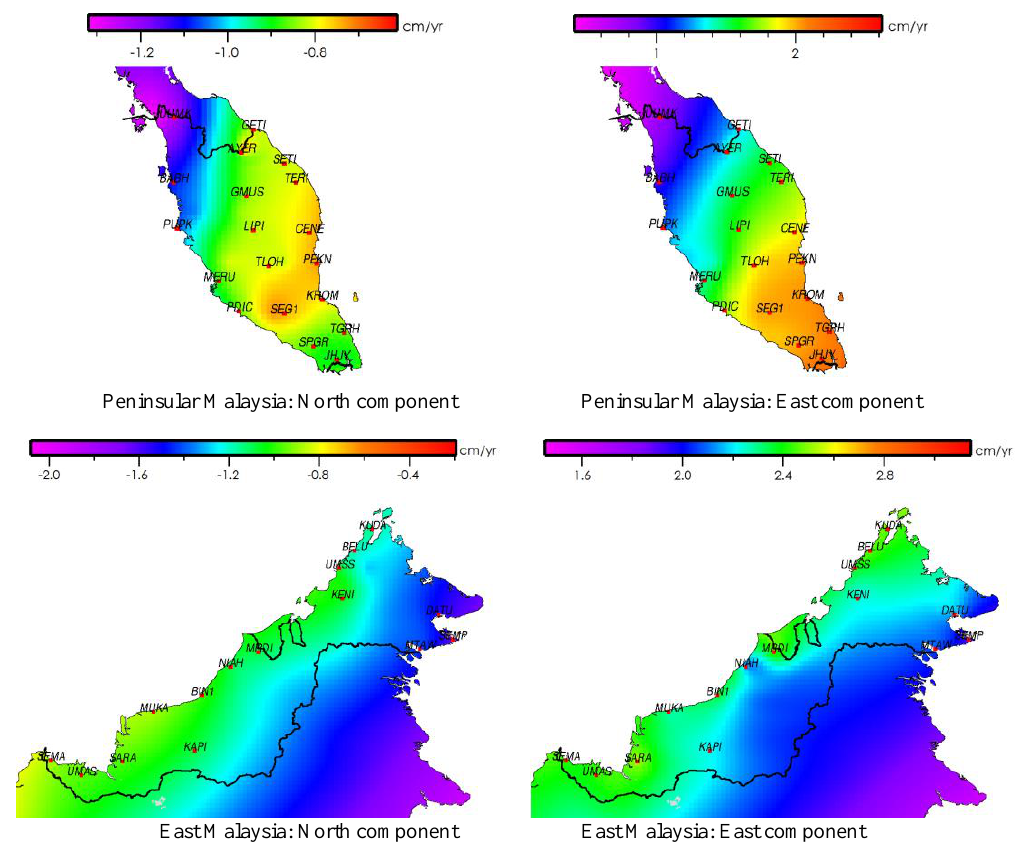
Figure 5. Malaysian 2008-2011 secular deformation model of north and east velocities using bilinear